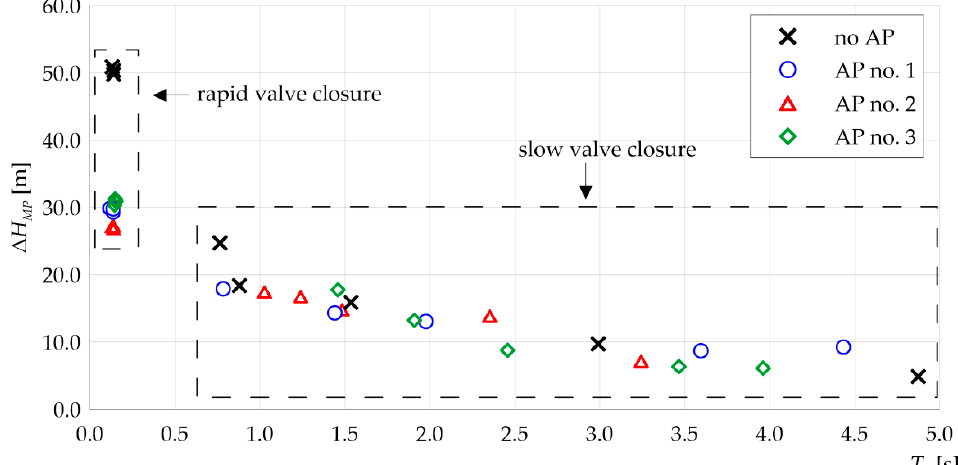
Figure 6. Values of maximum pressure increase in main pipeline for each experiment as a function of valve time closure (data obtained with sensor P M ).